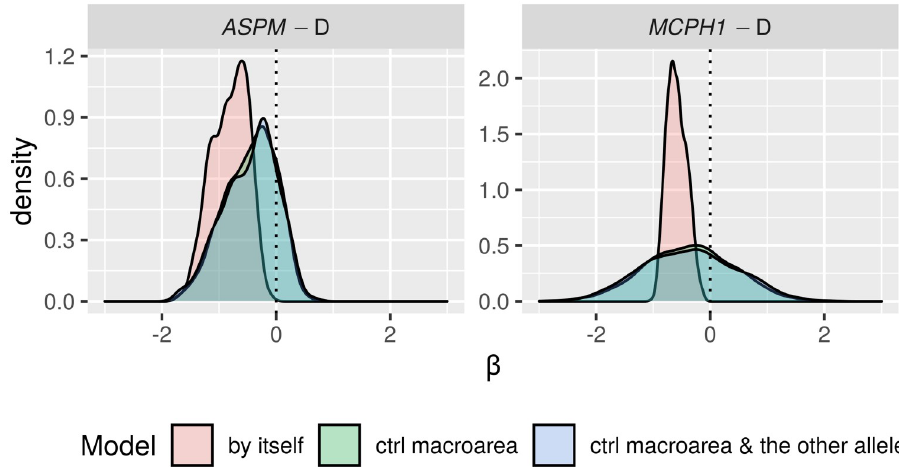
Fig 10. Distribution of the effect size β (horizontal axis) of ASPM -D (left) and MCPH1 -D (right) on tone1 in the restricted sampling regressions without controlling for macroareas (“by itself”, red areas), including macroarea as a fixed effect (“ctrl macroarea”, green areas), and including both macroarea and the other “derived” allele as fixed effects (“ctrl macroarea & the other allele”, blue areas). Each individual plot shows 0.0 (vertical dotted black thin line) and the distribution of the β ’s for the three “models” (the coloured areas). Please note that the y-axes vary between plots, but the x-axes are fixed for comparability. The more to the left of 0.0 a distribution is, the clearer the negative effect